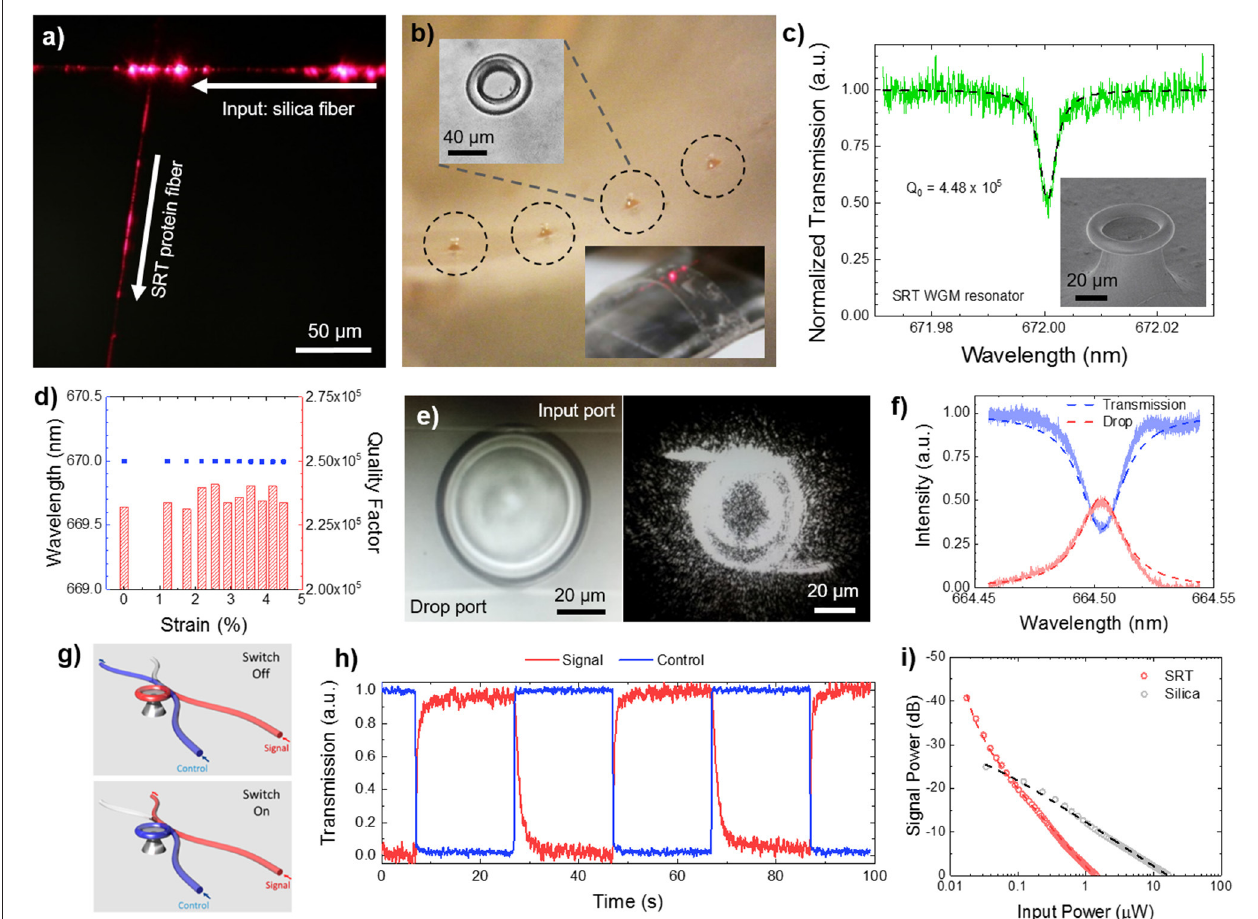
FIGURE 7 | Protein-based soft photonics. (a) All-protein optical waveguides, (b) protein whispering gallery mode microresonator arrays on flexible substrates, (c,d) high quality factor for protein resonators, with stable performance under bending deformation, (e,f) SRT-based add-drop filter, (g–i) SRT-based optical on/off switch. Reproduced with permission ( Yilmaz et al., 2017). Copyright 2017 American Chemical